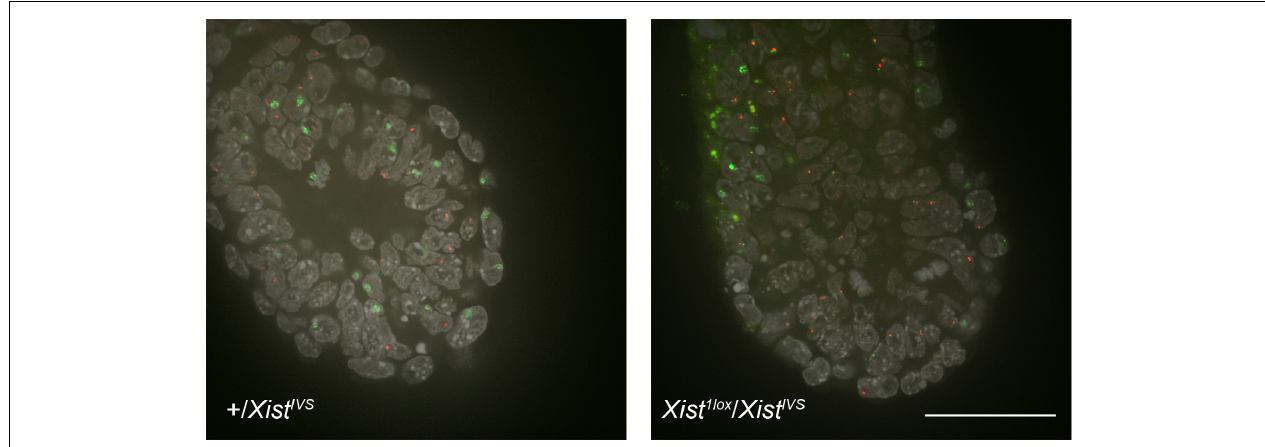
FIGURE 1 | Whole-mount RNA-FISH in the distal part of E6.5 embryos. Expression of Xist (green) and Atrx (red) was examined in +/ Xist IVS and Xist 1 lox / Xist IVS embryos recovered on E6.5. Six confocal sections of a 0.2- µ m interval obtained by confocal microscopy were projected into a single image. epi, epiblast; ve, vesceral endoderm. Scale bar = 100